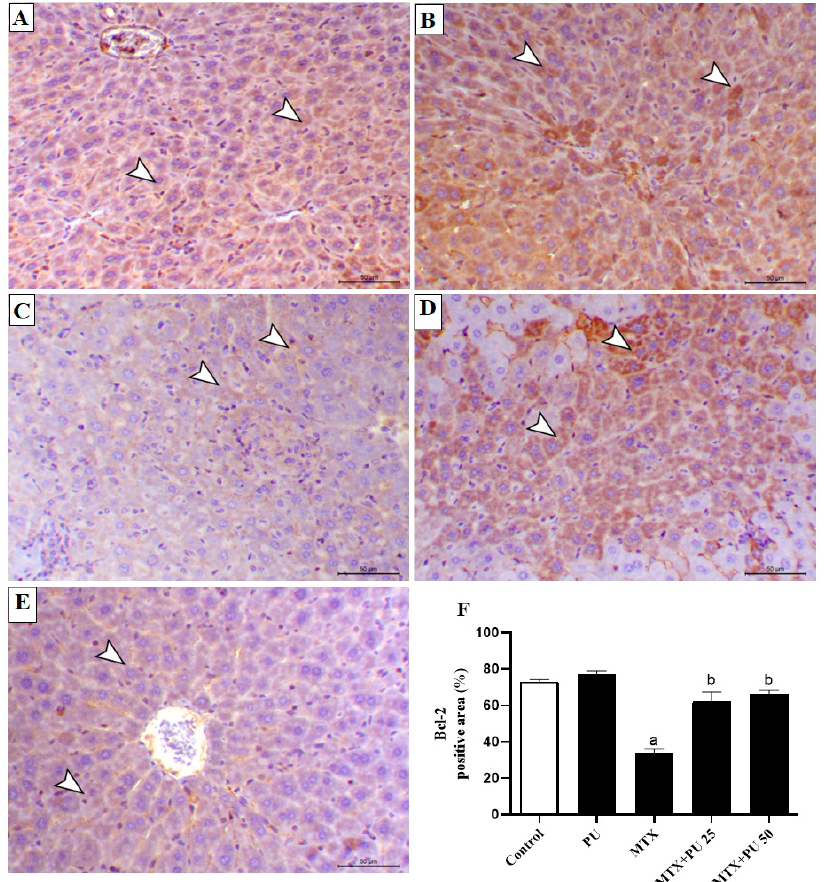
Figure 6. PU attenuates hepatic Bcl-2 in MTX-injected mice. Image of microscopic field of hepatic tissue from ( A ) control and ( B ) PU-treated mice showing high level of hepatocytes Bcl-2 immuno- expression (arrowheads), ( C ) MTX- injected mice showing marked decrease in hepatocytes’ Bcl-2 immunoexpression (arrowheads); ( D ) MTX-injected mice pre-treated with 25 mg PU demonstrating increased Bcl-2 immunoexpression within the hepatic tissues (arrowheads); and ( E ) MTX-injected mice pre-treated with 50 mg PU showing noticeable increase in hepatocytes’ Bcl-2 immunoexpression (arrowheads) (IHC, X200, Scale bar = 50 µm). ( F ) Image analysis of hepatic Bcl-2 immunostaining demonstrating significant decline of Bcl-2 level in MTX-injected mice and significant elevation of Bcl-2 level in both doses of PU-pretreated mice exposed to MTX. Results are expressed as mean ± SEM, ( n = 6). a indicates significant ( p < 0.05) vs. control, while b indicates significant ( p < 0.05) vs. MTX.